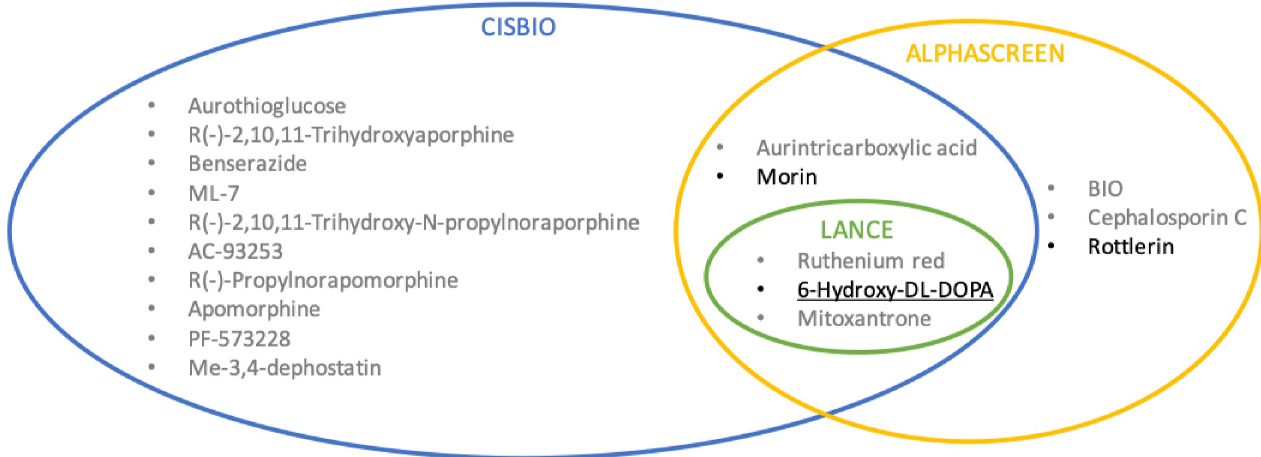
Fig 16. Venn diagram of LOPAC active compounds in all screening assays. Grey denotes compounds triaged in counter screening. Black denotes remaining active compounds.